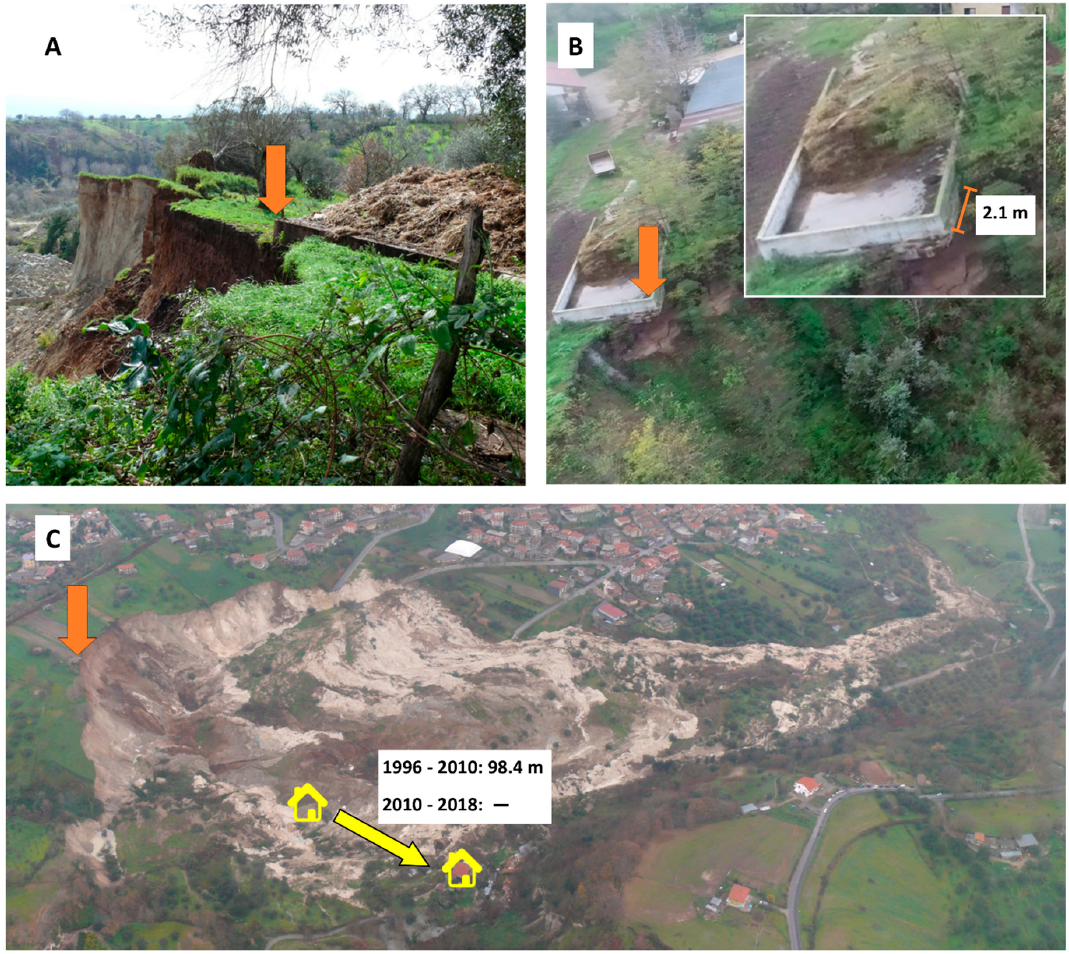
Figure 12. Evaluation of retrogressive evolution of the landslide: qualitative comparison between the terrestrial reconnaissance photograph ( A ) and the UAV survey ( B ); ( C ) measurement of the displacement of a building moved by the landslide.